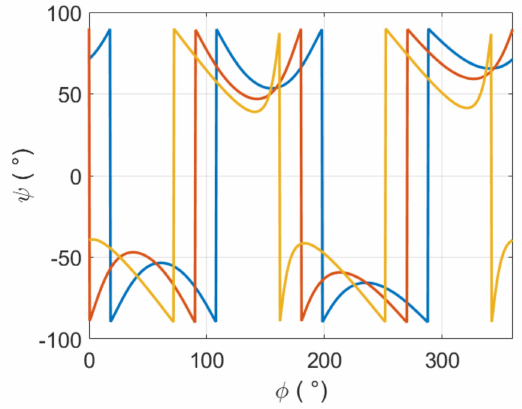
Figure 8. Relationship between ϕ and ψ